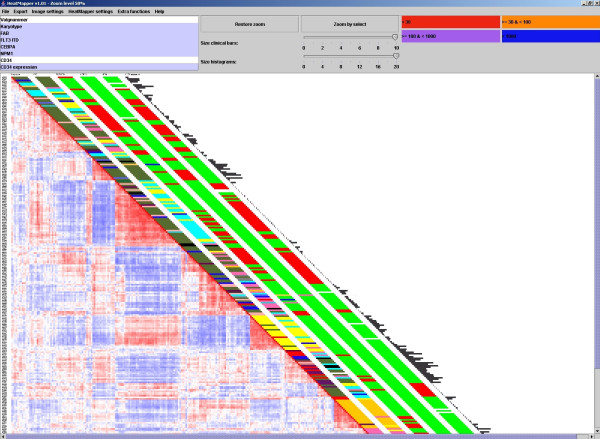
HeatMapper screenshot. The figure shows pairwise correlations between 285 samples of patients with Acute Myeloid Leukemia, as described previously [6]. The cells in the visualization are colored by Pearson's correlation coefficient values with deeper colors indicating higher positive (red) or negative (blue) correlations. Clinical and molecular data are depicted in the columns along the original diagonal of the heatmap. Karyotype and FAB classification based on cytogenetics are depicted in the first two columns (karyotype: normal-green, inv(16)-yellow, t(8;21)-purple, t(15;17)-orange, 11q23 abnormalities-blue, 7(q) abnormalities-red, +8-pink, complex-black, other-gray; FAB M0-red, M1-green, M2-purple, M3-orange, M4-yellow, M5-blue, M6-grey). FLT3 ITD, CEBPA and NPM1 mutations are depicted in the same set of columns (red bar: positive and green bar: negative). The expression levels of CD34 (probe set: 209543_s_at) in the 285 AML patients are plotted in the last column (bars are proportional to the level of expression).